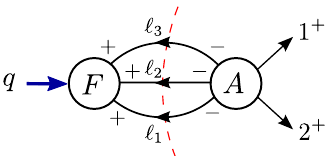
Figure 16 . Triple cut in the q 2 -channel of the two-loop subminimal form factor F (2)